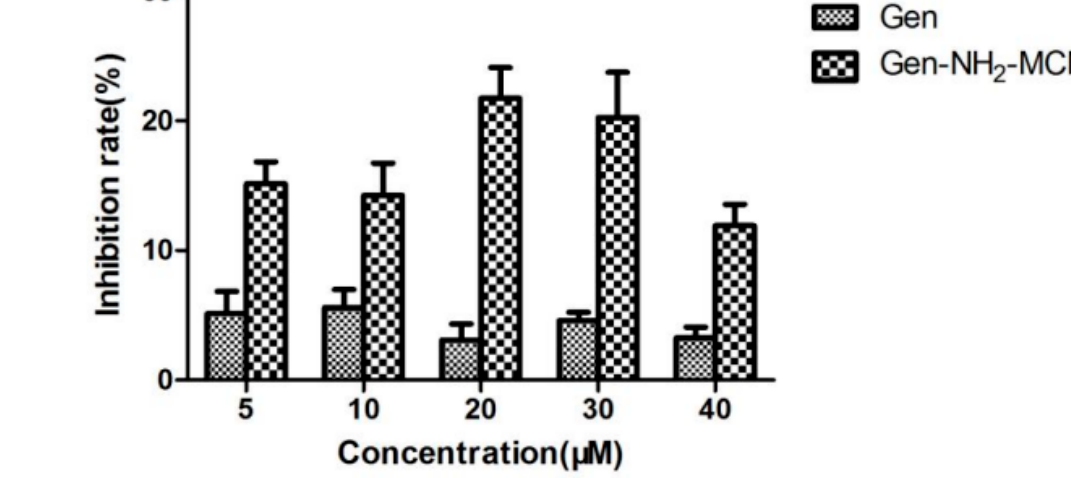
Figure 14. Gen-NH 2 -MCM-41@SA and Gen inhibited the attachment and replication of (RV) strain Wa in Caco-2